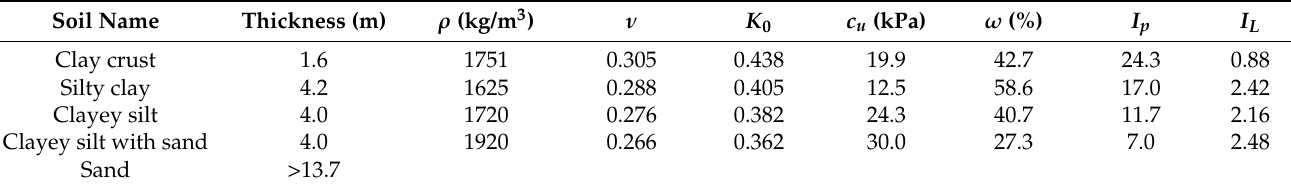
Table 1. Geotechnical properties of the